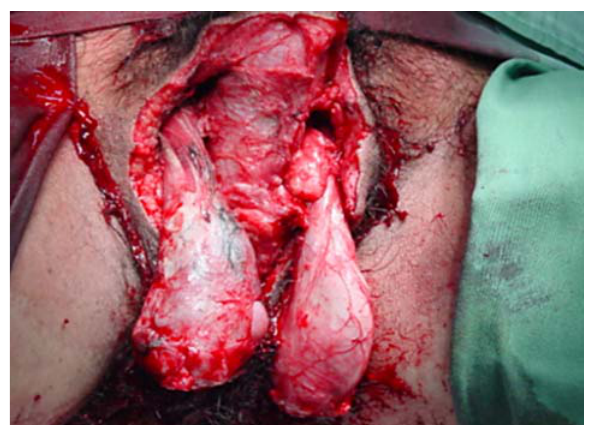
Figure 2 – Patient presenting Fournier’s gangrene after debride- ment. The lesion affected the scrotum and the penis. Note bilateral exposure of the testes.